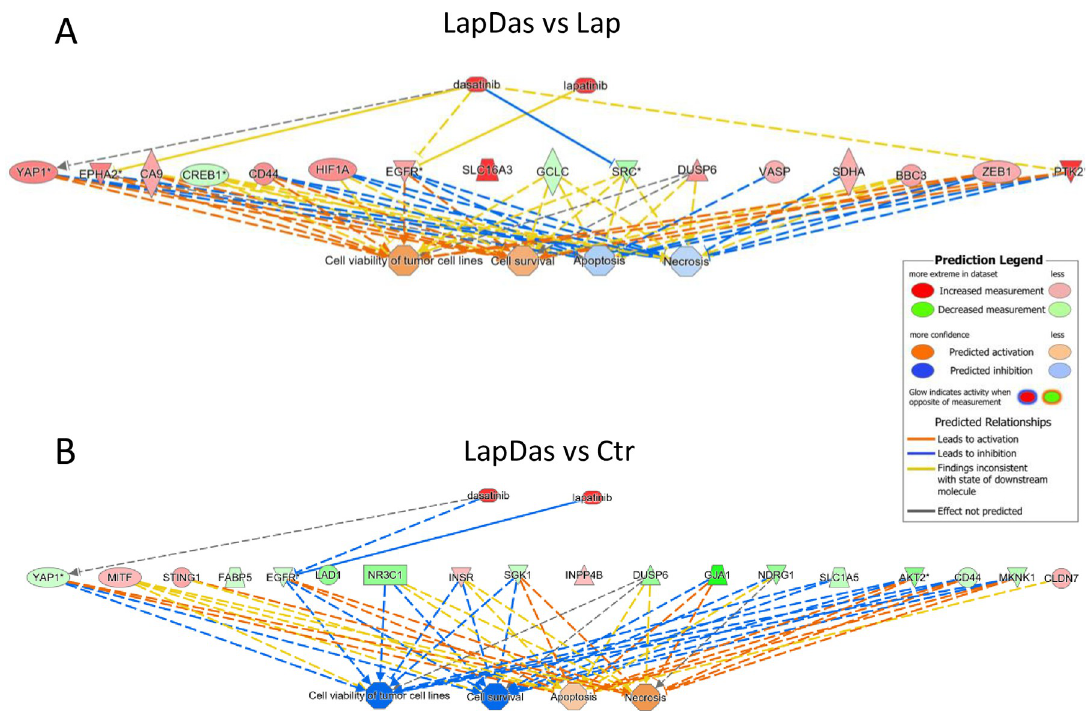
Fig 8. Predicted effects on protein expression upon treatment. The IPA core analyses and predictions of downstream regulations of the proteins measured in tumors treated with lapatinib and dasatinib compared to A) lapatinib alone, and B) control tumors. The predicted effects of the changes in protein expression in lapatinib + dasatinib (LapDas) vs lapatinib (Lap) show activation of cell viability and survival, and inhibition of apoptosis and necrosis (A). This is the opposite of what is predicted when comparing the changes in protein expression in LapDas vs control (Ctr) tumors (B). The prediction legend explains the color codes of the predicted inhibition and activation. For visualization purposes, only proteins with an |FC| > 0.3 and p -value < 0.05 are shown. All significantly regulated proteins are listed in Tables 1 and